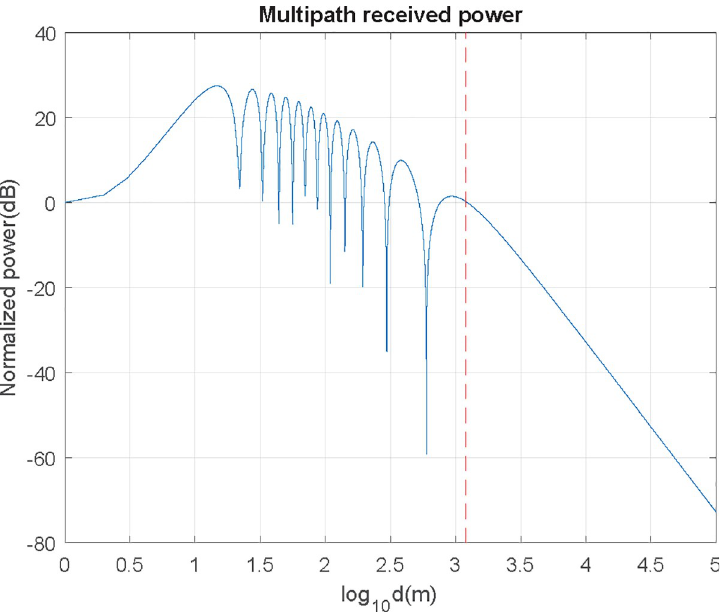
Fig 7. Received power at f = 900 MHz, having h AUT = 2 m and h UAV = 50 m.